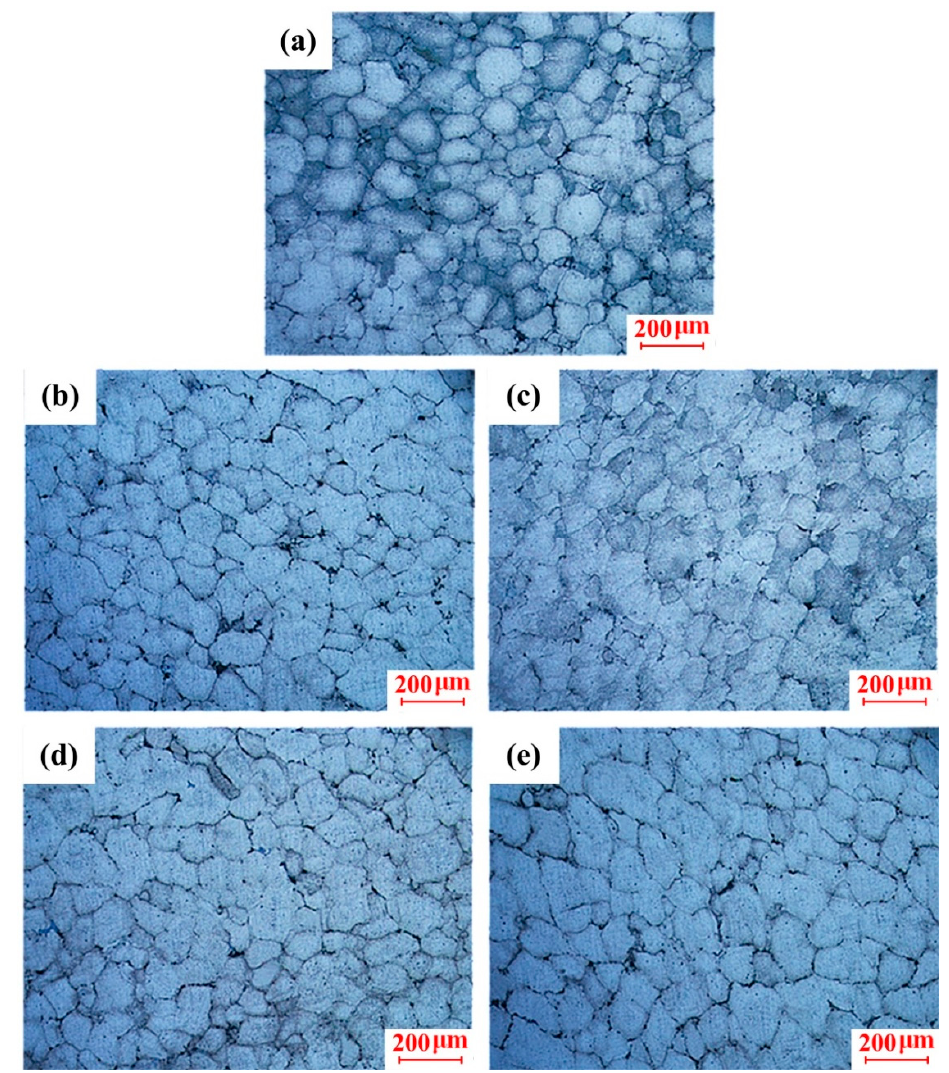
Figure 8. Microstructure of the scroll under different squeeze pressures: ( a ) 25 MPa, ( b ) 50 MPa, ( c ) 75 MPa, ( d ) 100 MPa, and ( e ) 125 MPa.